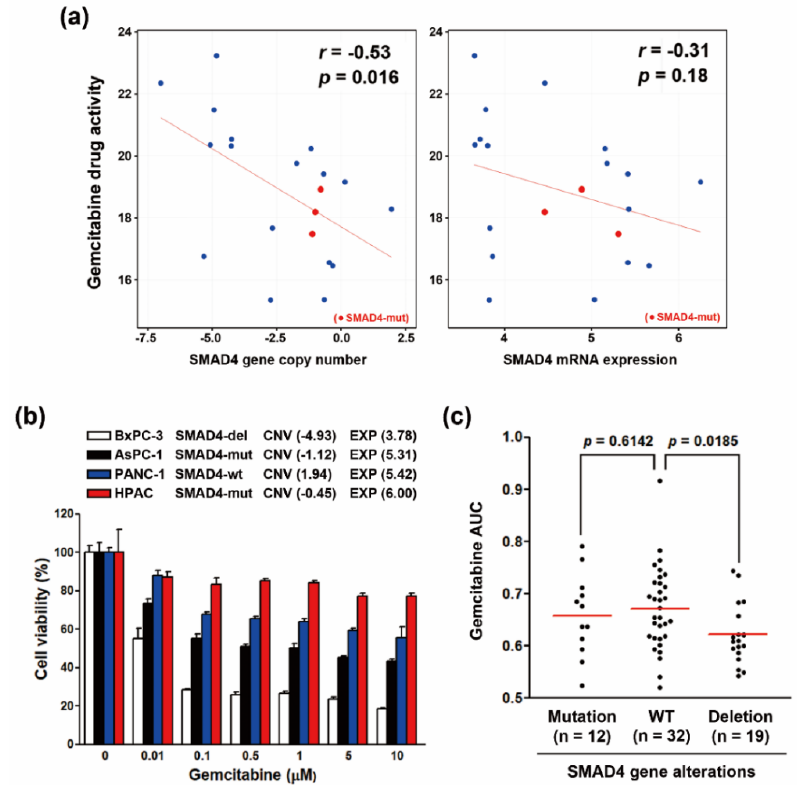
Figure 4. SMAD4 deletion correlated with an increase in gemcitabine sensitivity in PDAC. ( a ) The correlations between SMAD4 gene copy numbers (left part) / mRNA expression (right part) and gemcitabine drug activity were obtained from the CTRP database via an online tool, the CellMinerCDB; ( b ) PDAC cell lines were treated with gemcitabine for 72 h, and then cell viability was determined by an MTT assay. The SMAD4 mutation status was obtained from the CCLE database (missence mutation and frameshift insertion in AsPC-1, and HPAC cells, respectively). BxPC-3 cells harbored a homozygous deletion of SMAD4 gene [16] . The values for SMAD4 copy number variation (CNV) and expression (EXP) were obtained from the CellMinerCDB database (CTRP-Broad-MIT data); ( c ) Chemosensitivity profiles for PDAC patient-derived organoids were obtained from a previous study. Values shown are the area under the curve (AUC) for each drug. Higher or lower AUC (area under the curve) indicated less or more responsive to each drug,